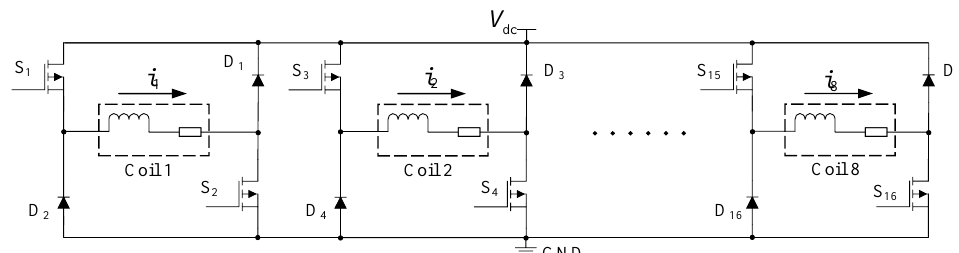
Figure 6. Half-bridge circuit of the SPA for the four DOF AMB .